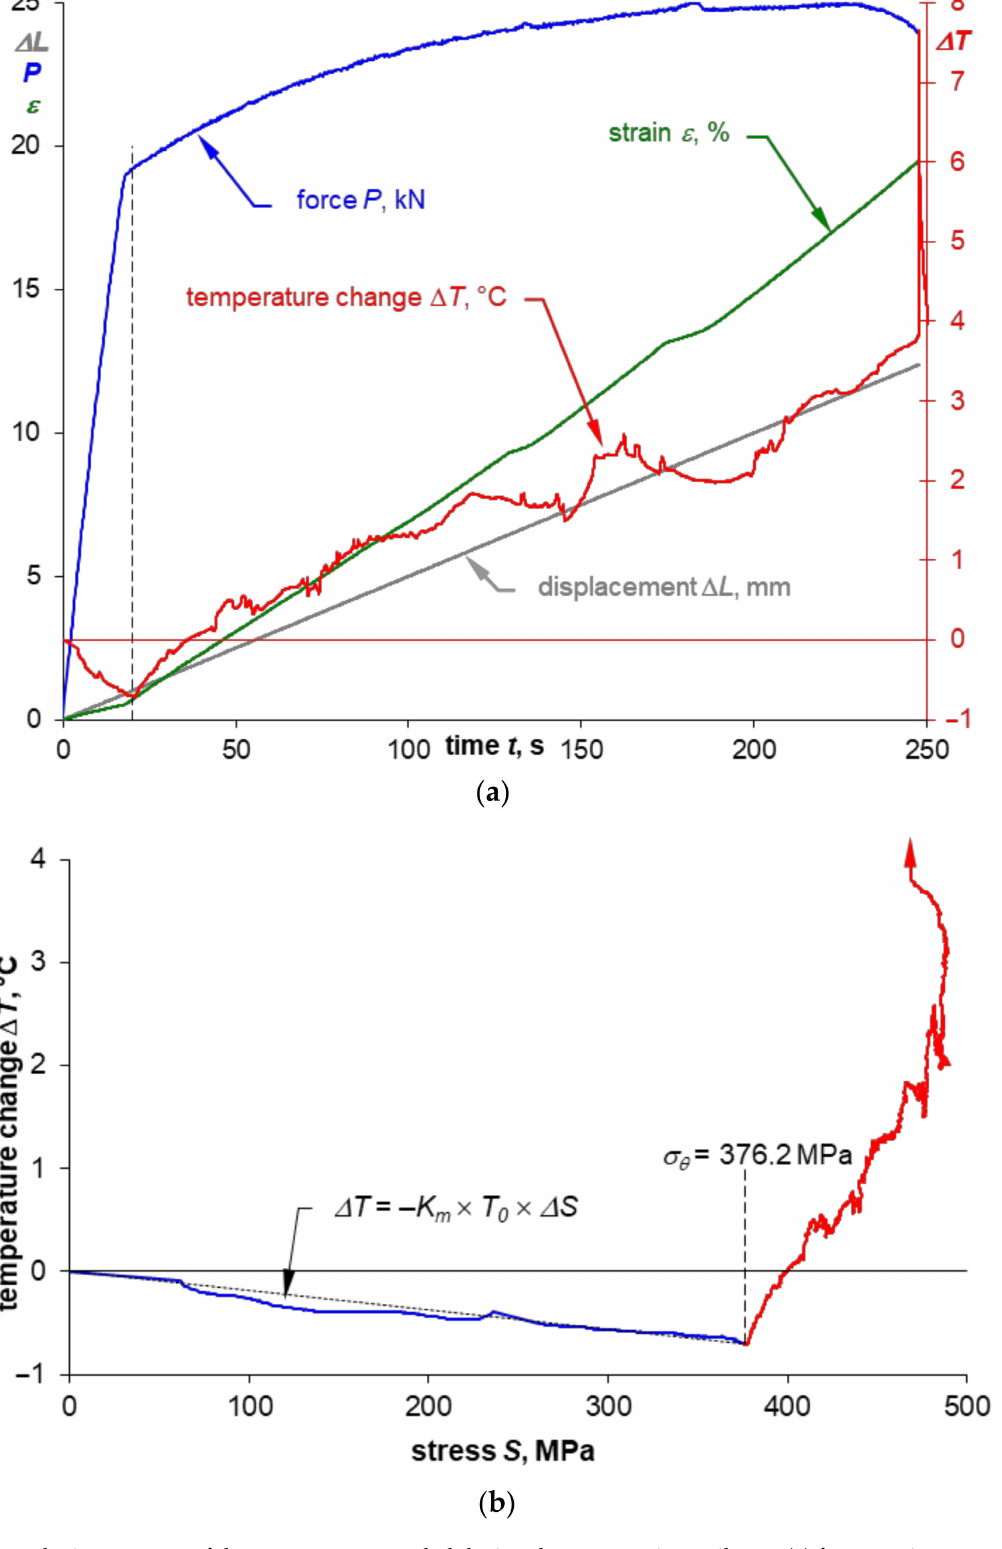
Figure 7. Sample time courses of the parameters recorded during the monotonic tensile test ( a ) for a specimen made of 0.16” thick 2024-T3 sheet plate cut parallel to the rolling direction and the temperature-strain relation ( b ) including the marking of the thermoelasto-plastic limit stress σ θ